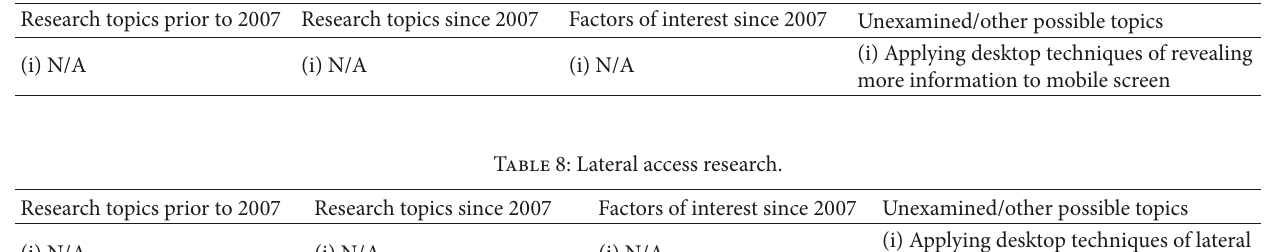
Table 7: Revealing more information research.